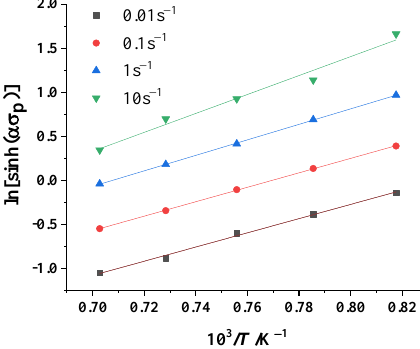
Figure 5. Relationship between 1/ T and ln[sinh( α p )].